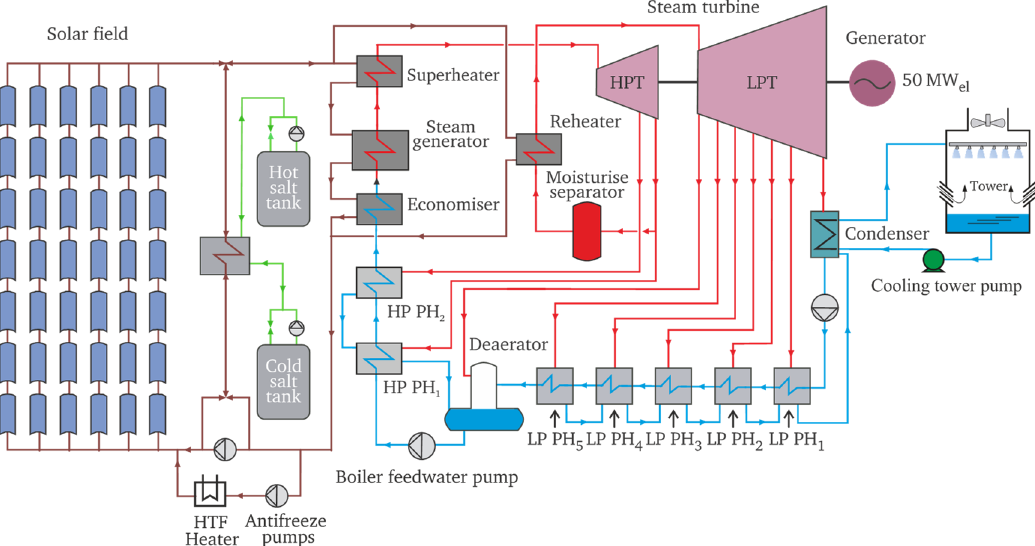
Figure 2. Parabolic trough solar power plant (PTSPP).